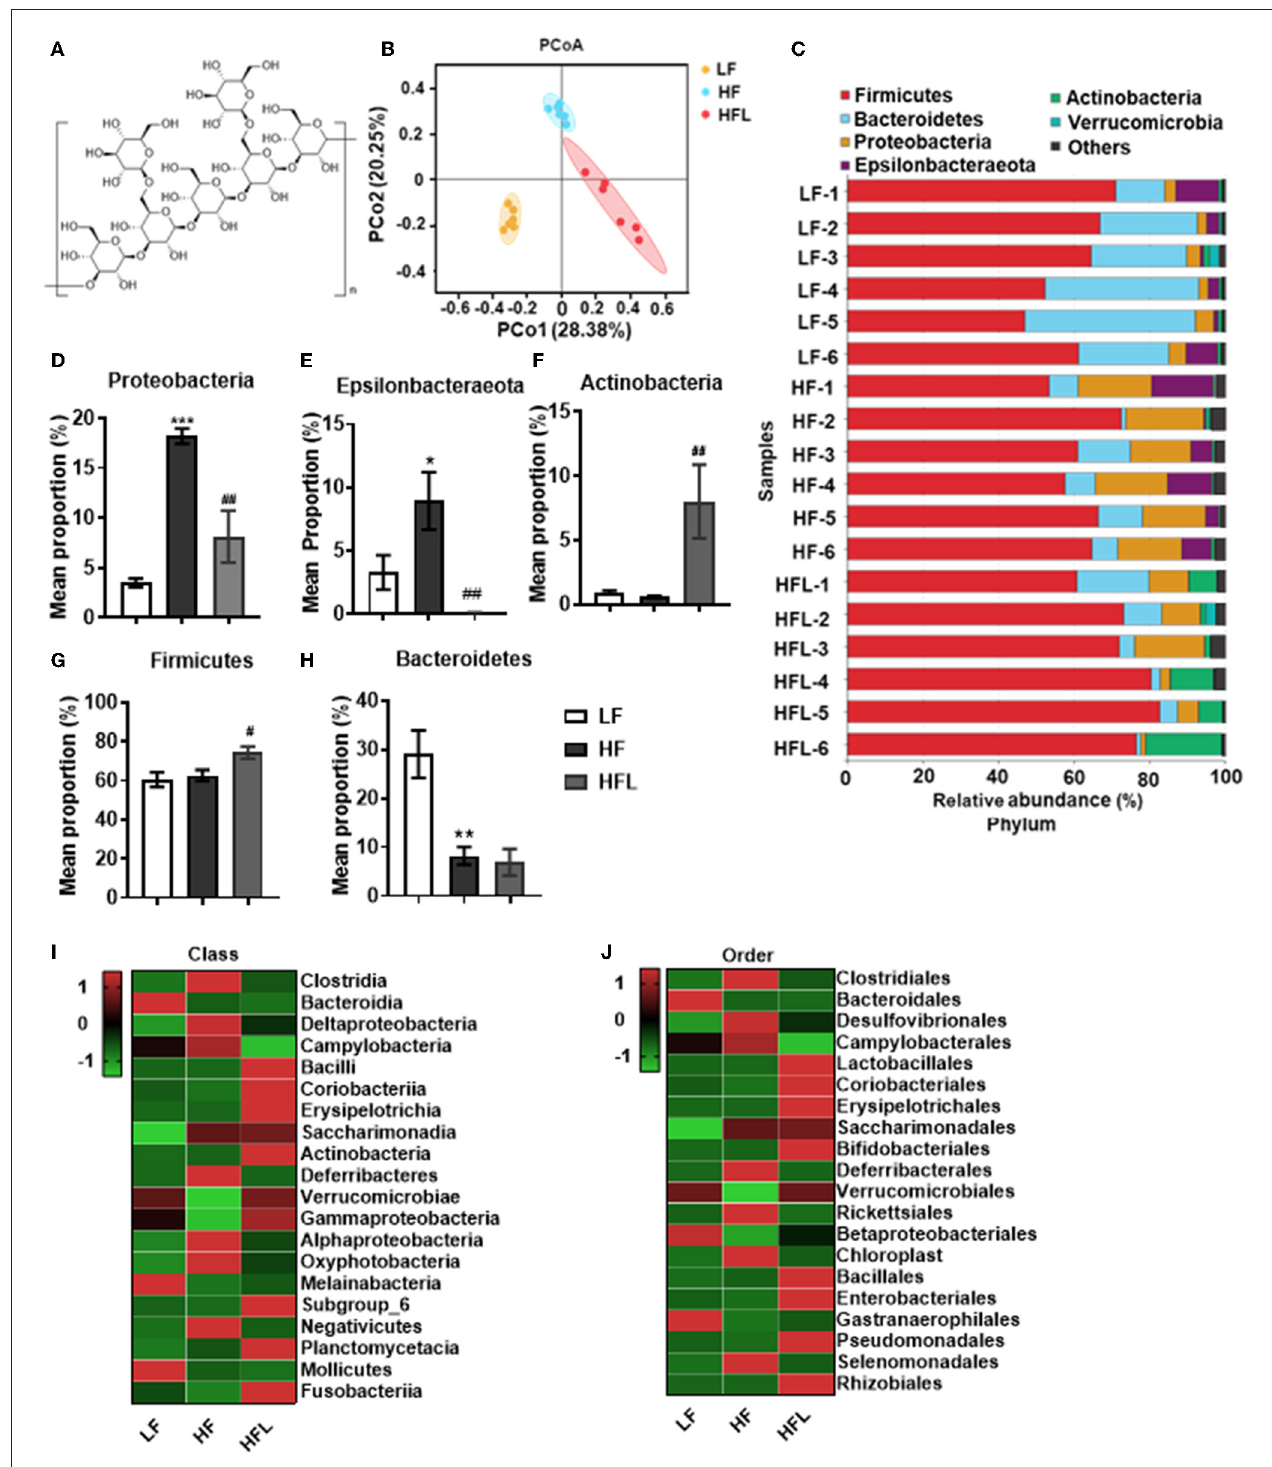
FIGURE 1 | Lentinan improved HF diet-induced dysbiosis. Cecal contents microbiota composition was analyzed by 16S RNA sequencing. (A) The chemical structure of lentinan. (B) PCoA of community dissimilarity. (C) The taxonomic composition analysis at phylum levels among three groups. (D–H) Relative abundance of phylum. Proteobacteria (D) , Epsilonbacteraeota (E) , Actinobacteria (F) , Firmicutes (G) , and Bacteroidetes (H) . (I,J) The top 20 bacteria in relative abundance at the levels of class (I) and order (J) in three groups. The color of spots in the left panel of heatmap represents the Z-scores, demonstrating that all groups were represented by the Z-scores as the relative abundance levels [Z score = (actual relative abundances of a species in a specific group – mean relative abundance of the three groups)/standard deviation]. Values are means ± SEM ( n = 6). * p < 0.05, ** p < 0.01, *** p < 0.001 vs. LF mice; # p < 0.05, ## p < 0.01 vs. HF mice.